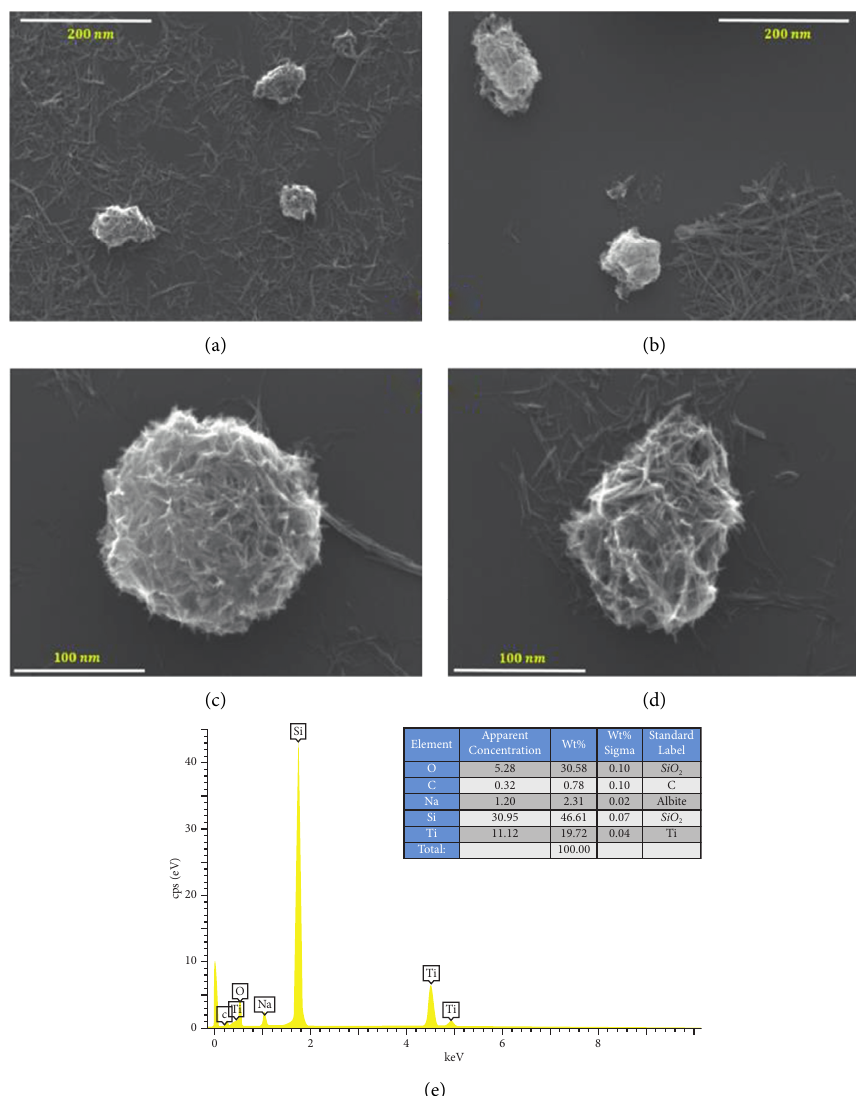
Figure 3: (a–d) SEM micrographs of the Na-TiNT in different regions; (e) EDS peaks for the Na-TiNT